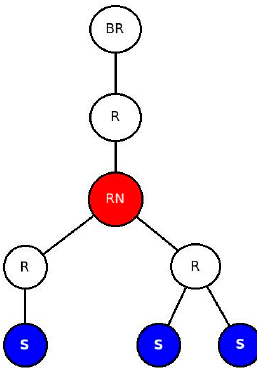
Figure 24. Network Topology for Noisy Networks.